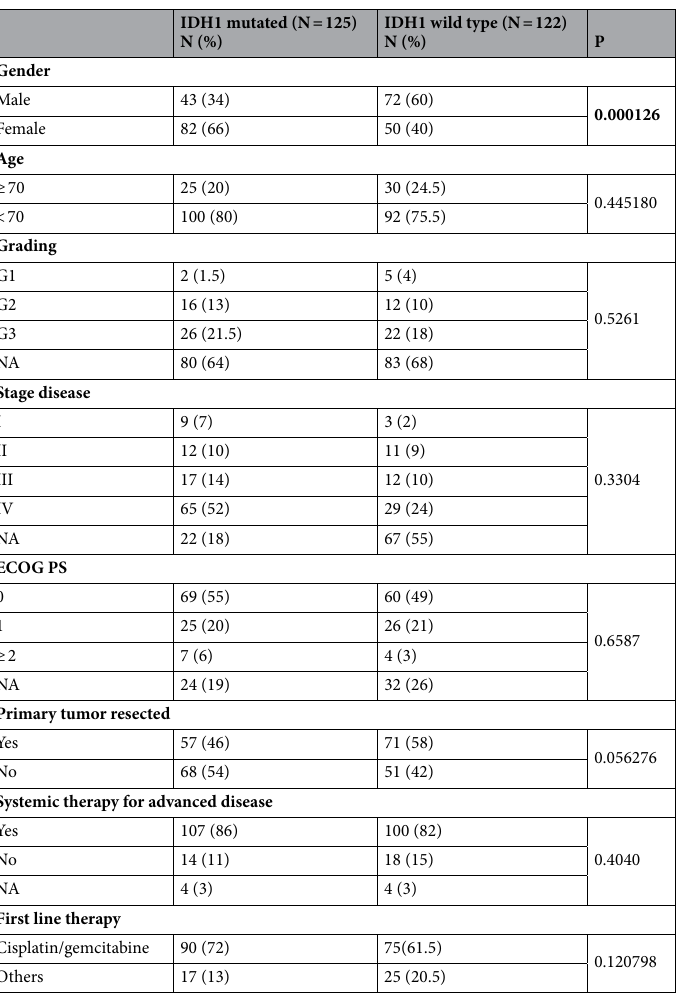
Table 1. Patients’ characteristics according to the IDH1 status. Significant values are in